Question: Summarize what this figure shows in one sentence.
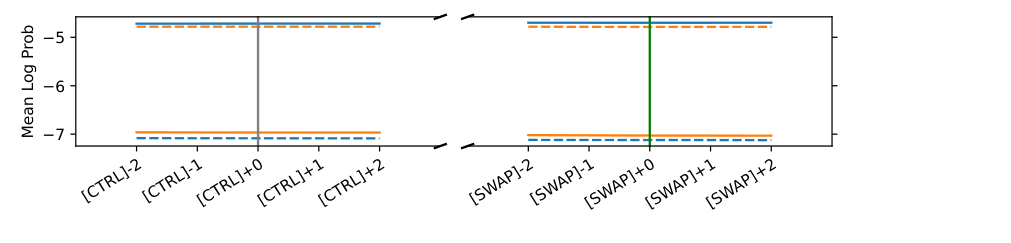
Answer: Position independence for BIOS. Top: Mean log probs for entity interventions. Bottom: Mean log probs for attributes. Different from Fig. 4, we only compute the local neighborhood around the control and swapped conditions.